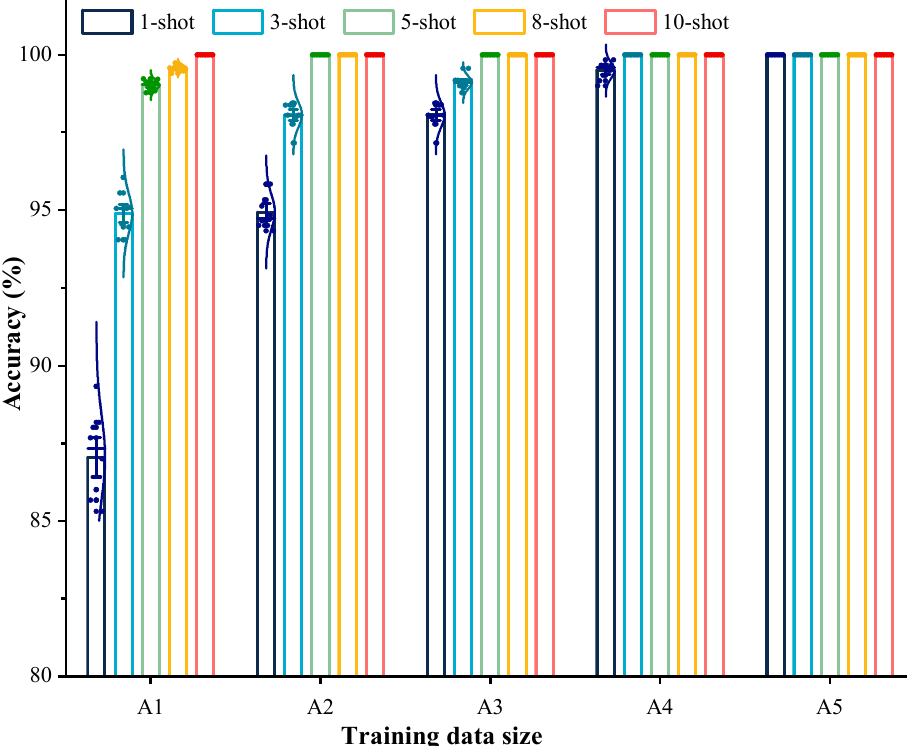
Figure 6. Diagnostic performance of the WRRN method under different training dataset size for the different setting.